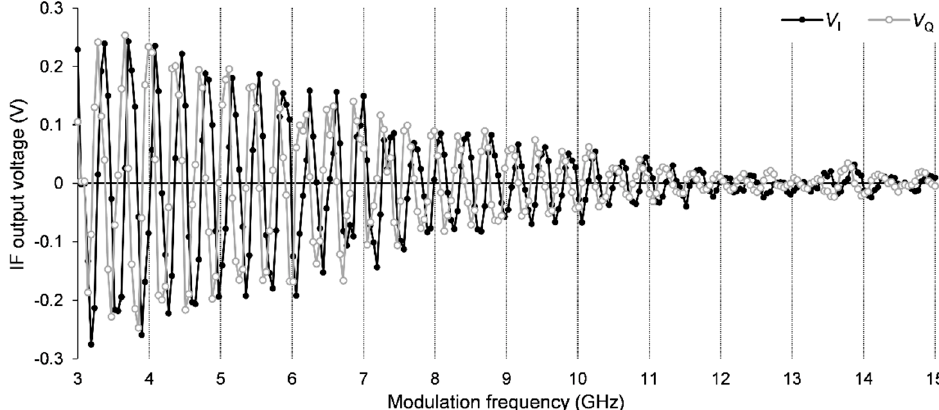
Figure 2. Measured IF output signals in the case of a single target, when the motor stage is placed at 0. The modulation frequency was scanned from 3 to 15 GHz in 256